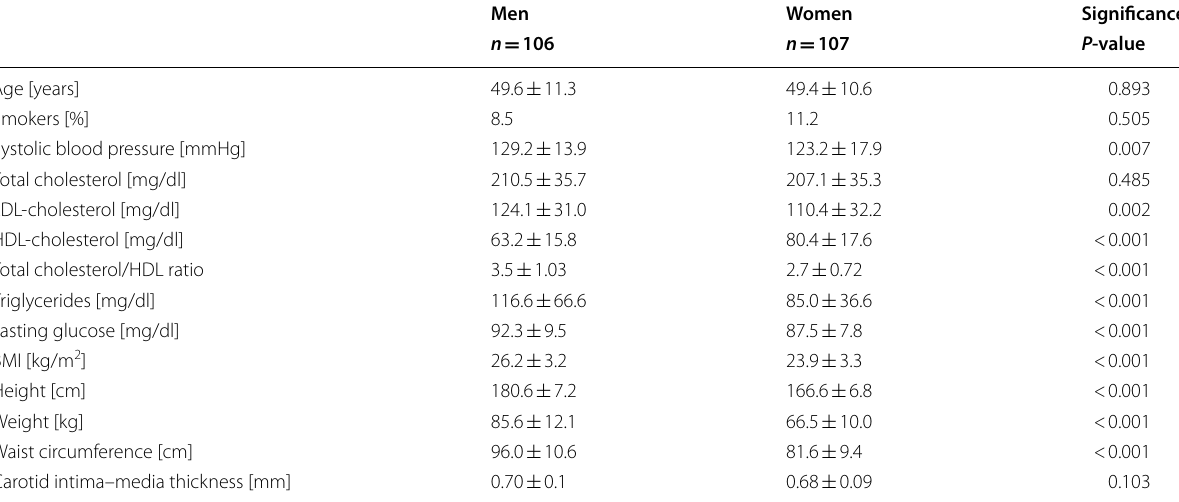
LDL low-density lipoprotein, HDL high-density lipoprotein, BMI body mass index